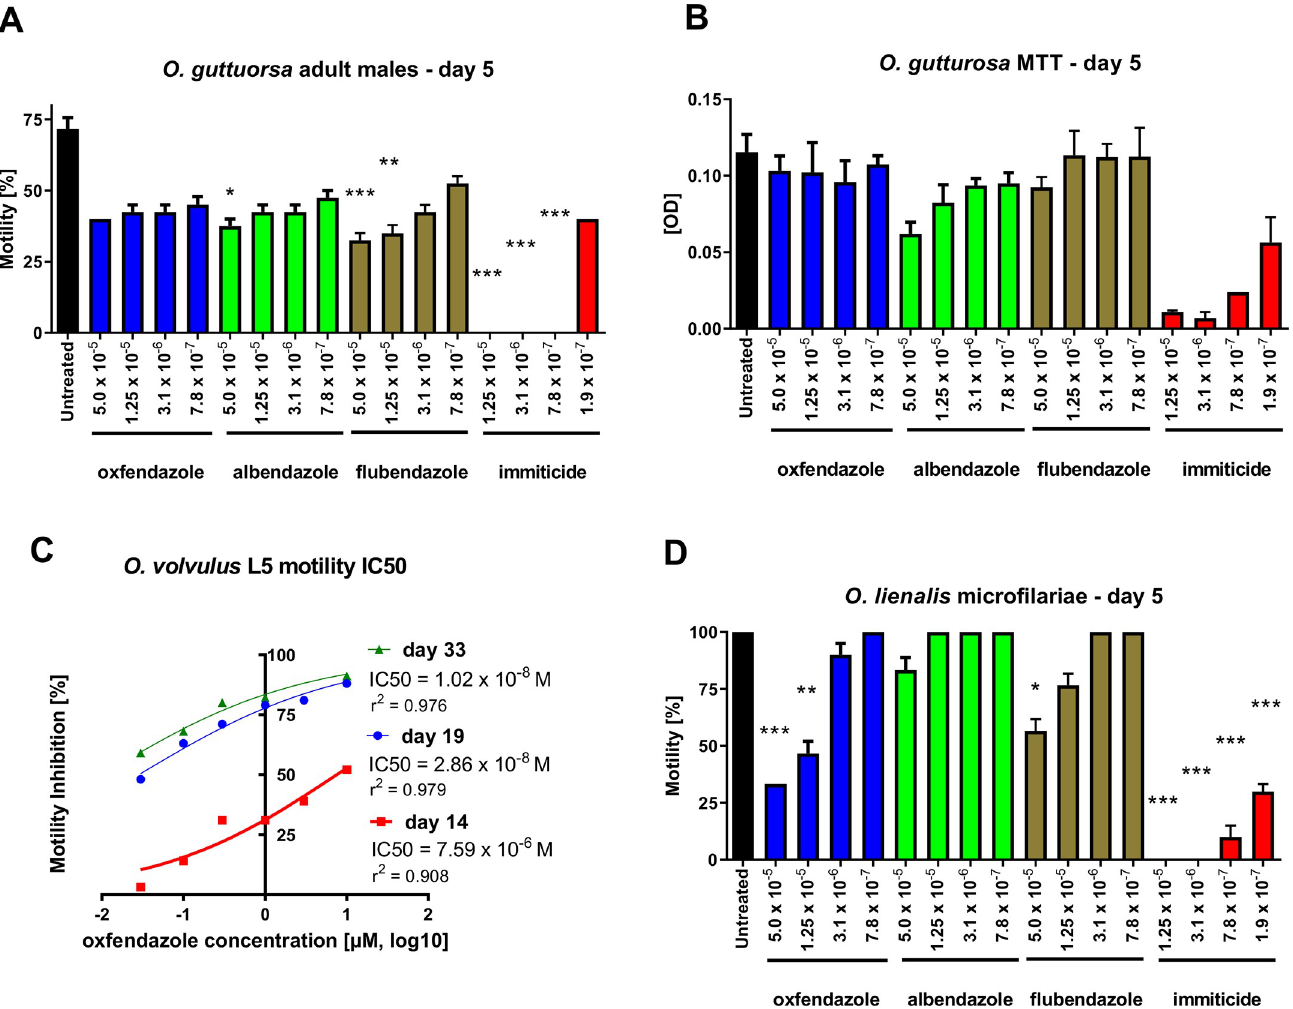
Fig 1. Oxfendazole has a moderate effect on O . gutturosa and O . volvulus adult worm motility in vitro . Onchocerca parasites were exposed to oxfendazole, albendazole, flubendazole and Immiticide (melarsomine used as a positive control) at the final concentrations indicated. (A) O . gutturosa adult male motility at 120 h. (B) O . gutturosa adult male MTT assay represented as mean optical density (OD) values at 120 h. For (A) and (B), means + SEM from 4 individual adult worms per drug concentration and 6 untreated adult worms are shown. For Immiticide, 2 adult worms per concentration were used. Vertical lines represent the standard deviation. (C) O . volvulus pre-adult L5 worms were cultured with oxfendazole over 14 days followed by 19 days in complete media without drug. Shown is the IC50 of the motility inhibition at 14 (red square), 19 (blue circle) and 33 days (green triangle) of culture. Each condition was assayed with 7–10 worms total divided in two replicate wells. (D) O . lienalis microfilariae motility at 120 h. Means + SEM from 10 individual worms per drug concentration and 10 untreated worms are shown. Vertical lines represent the standard deviation. (A) Kruskal-Wallis H-test: χ 2 = 49.0, df = 17, p < 0.0001 followed by Dunn’s multiple comparison test;